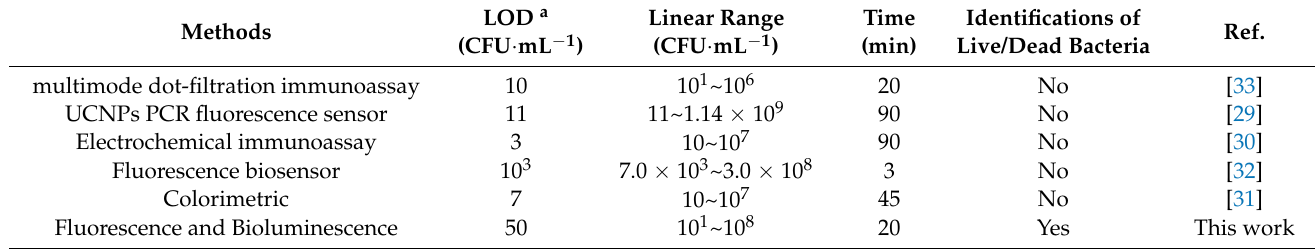
Figure 7. Plaque produced after dilution of phage stock solution by 10 6 times for ( A ) E. coli , ( B ) Acinetobacter Baumann, ( C ) V.P, ( D ) S.A, ( E ) L.M, and ( F ) S.T with P1, ( G ) P1, ( H ) P2, and ( I ) PBS with MB. Table 1. Comparison of methods to detect